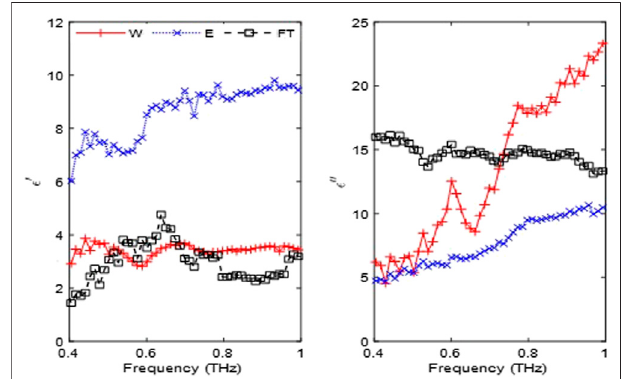
FIGURE 4 | the calculated complex permittivity of Water (W), ethanol (E) and FuelTreatment(FT) (Left) realpart ofpermittivity (Right) imaginary partof the